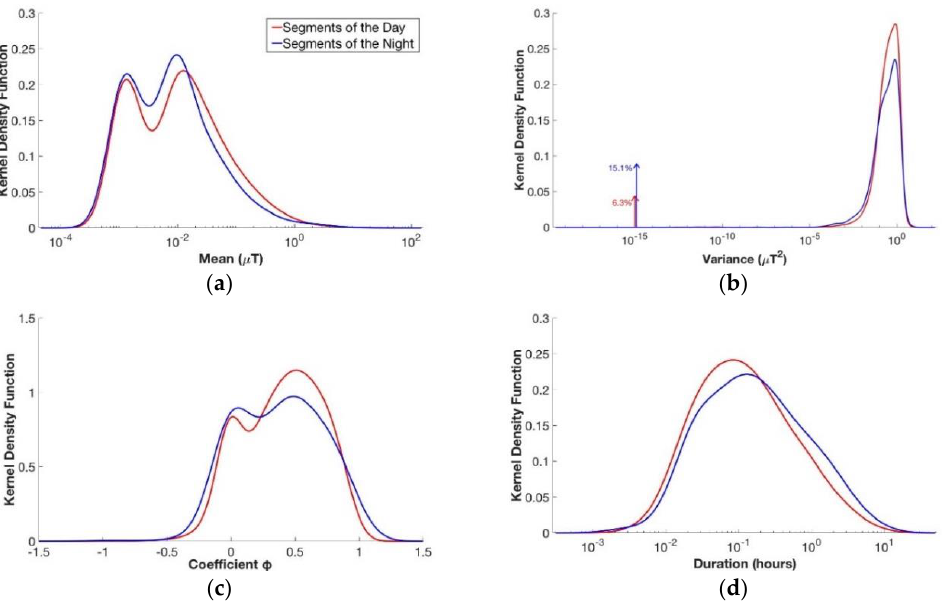
Figure 2. Estimated kernel density function for the four variables of the segments of the day (in red) compared with estimated kernel density function for the four variables of the segments of the night (in blue); from above to down, left to right: ( a ) mean µ , ( b ) variance σ 2 , ( c ) coefficient ϕ , and ( d ) duration